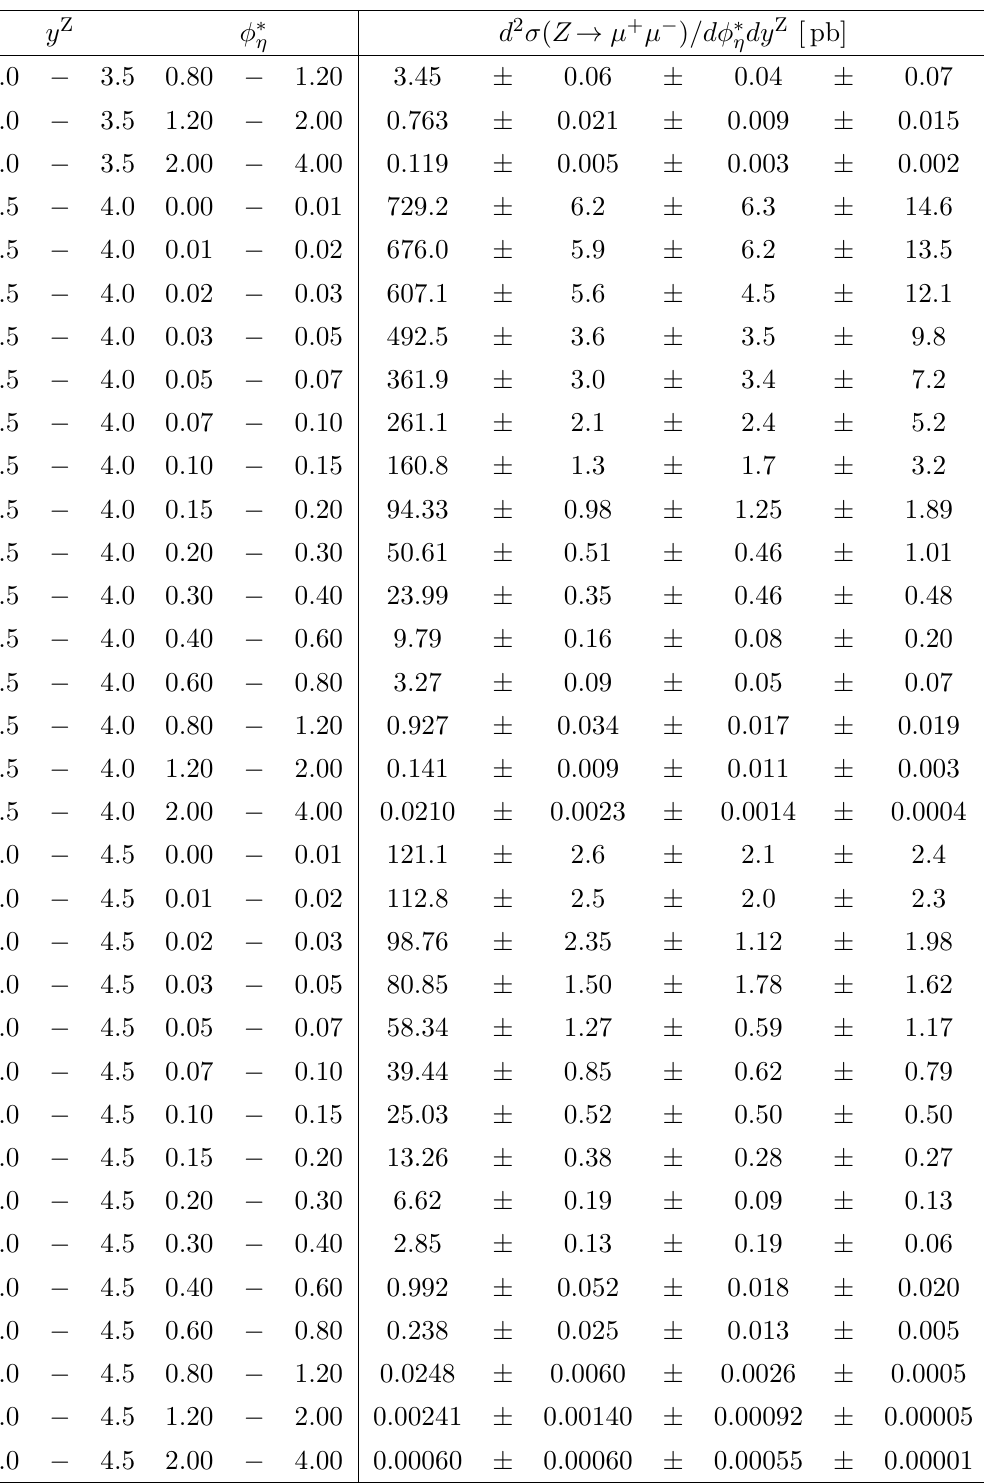
Table 18. Measured double differential cross-sections in interval regions of y Z and φ ∗ uncertainty is statistical, the second systematic, and the third is due to the